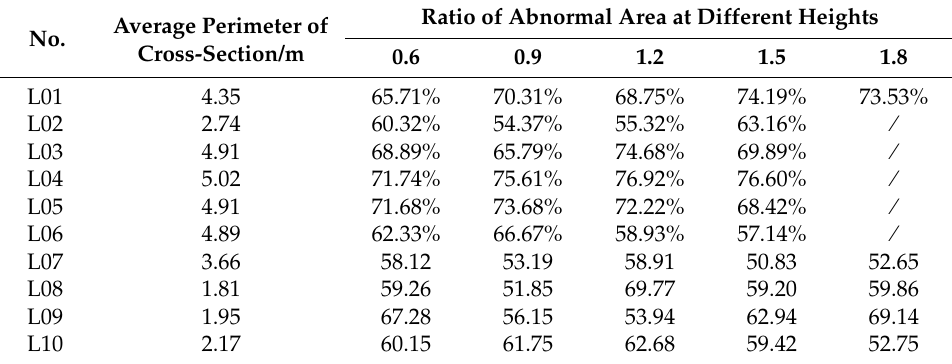
Figure 12. The detection result of tree L05 in the Summer Palace. ( a ) The willow tree in the field; ( b ) The trunk reconfiguration model; ( c ) The 3D analysis result; ( d ) The rejuvenation in order to compare with the detection results. Figure 12d shows the rejuvenation of L05. It can be observed that the inside of the trunks is almost empty, which are supported only by iron stents and ceramsite. The external bark is incomplete, and needs to be repaired with false barks. It is verified that GPR technology can detect the anomaly inside the trunk non-invasively by comparing the detection results and the actual situations in rejuvenation. The method provides a theoretical basis for the health assessment and rejuvenation of the trunk.